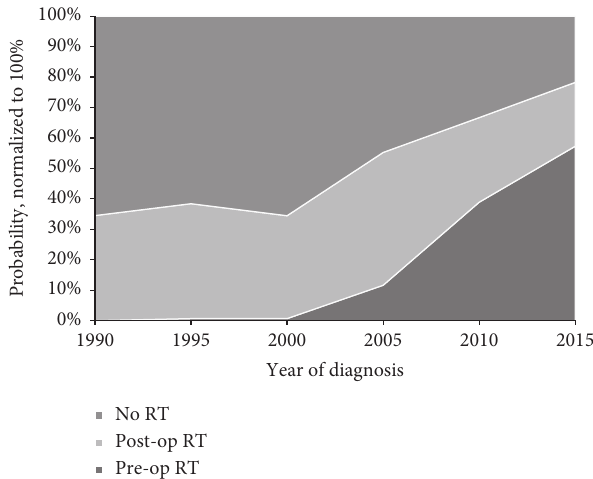
Figure 4: The use and the timing of RTduring the study period per year in localized